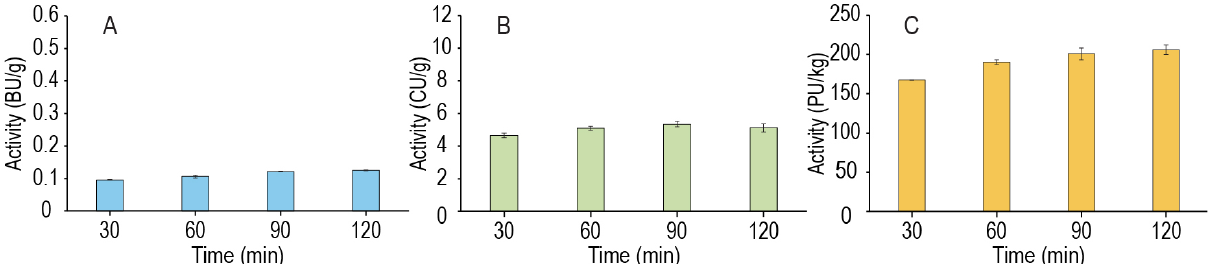
Figure 6. Enzyme activity extracted into the mash of the 40 °C enzyme extraction phase samples of β -amylase ( A ), α -amylase ( B ), and limit dextrinase ( C ). Activity was assayed as described in Section 2.5.